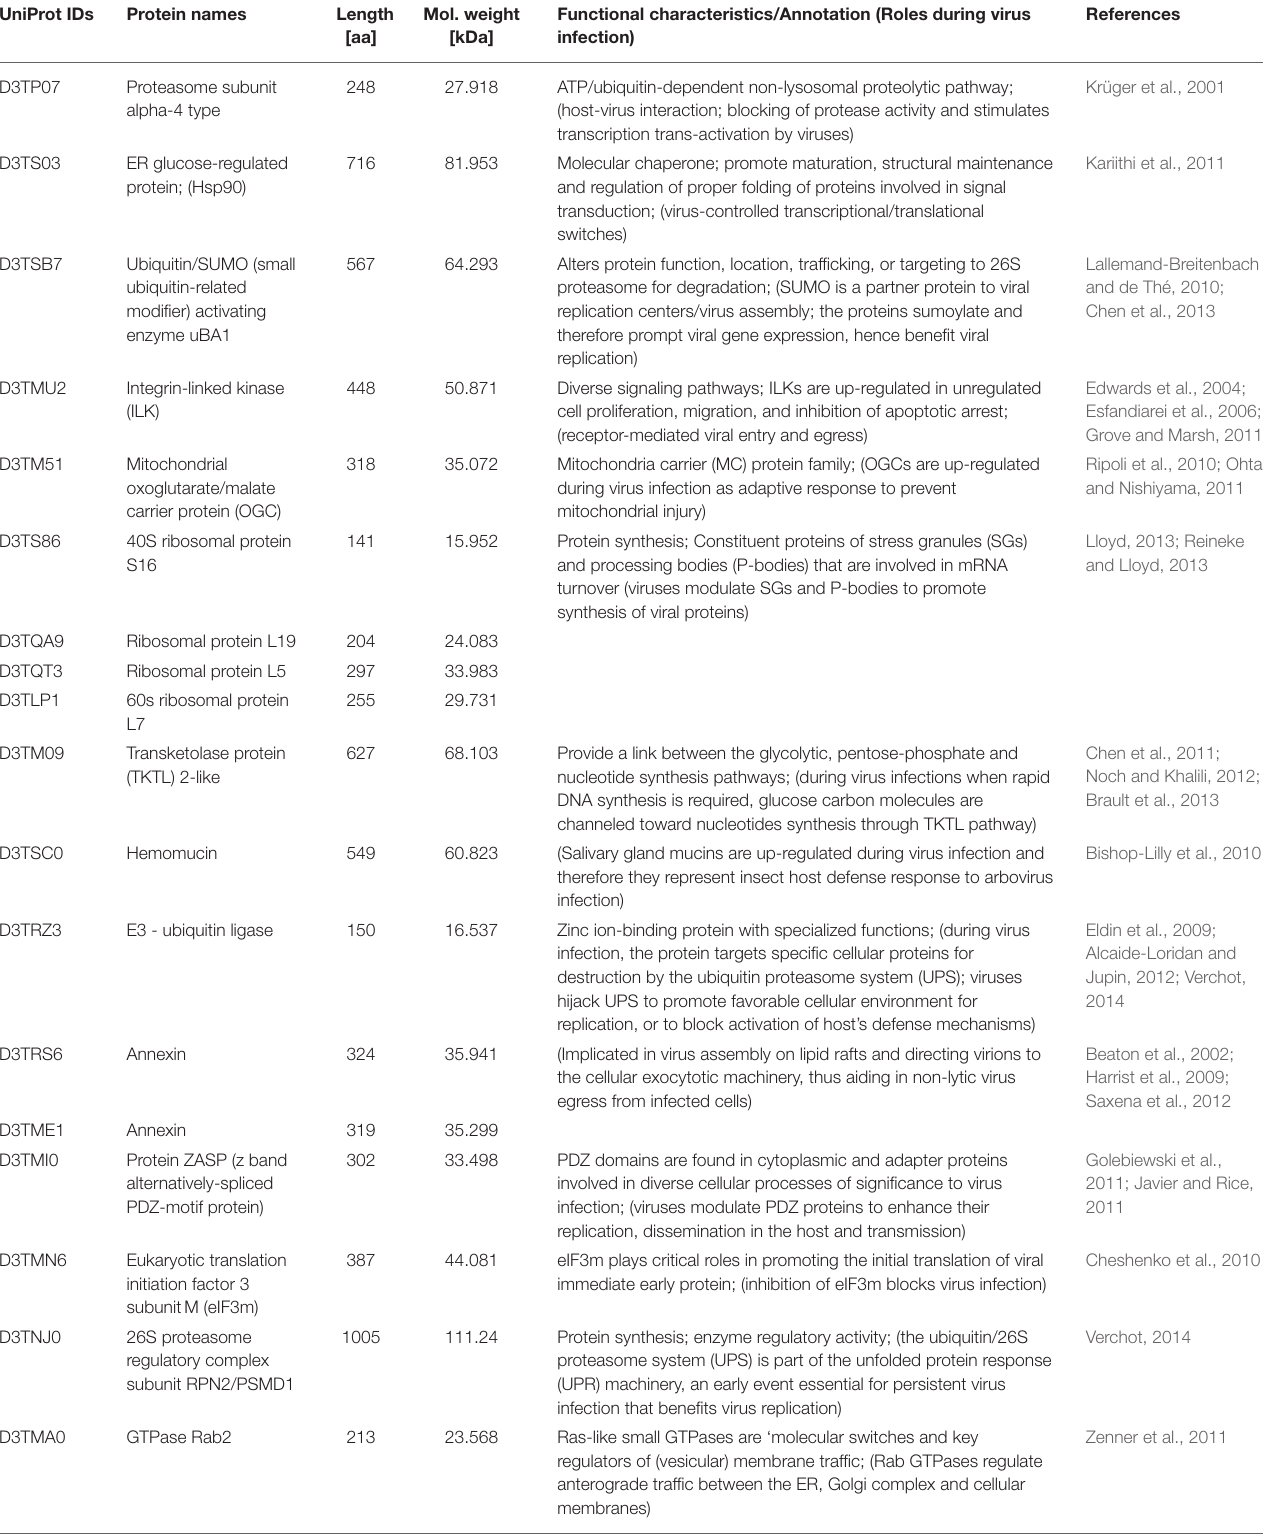
TABLE 1 | Twenty-three host proteins that were more than 100-fold up-regulated in the GpSGHV-infected G. pallidipes but were down-regulated in the proteome of virus-infected G. m. morsitans . UniProt IDs